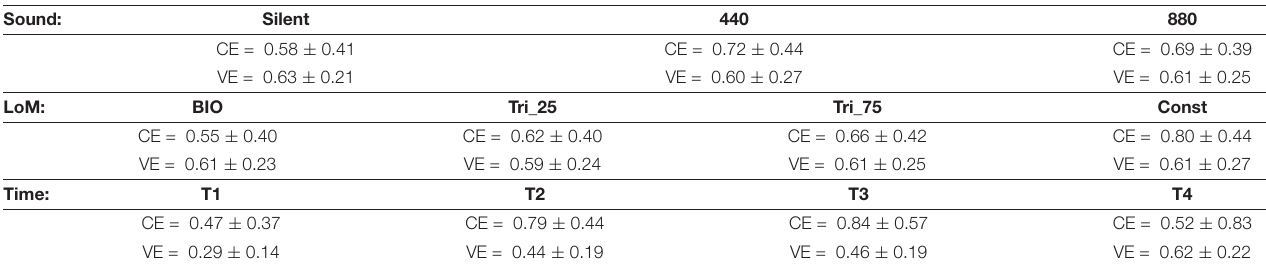
TABLE 1 | Results of Experiment 1 – Constant Error (CE) and Variable Error (VE) for the three main factors: Sound, Law of Motion (LoM), and